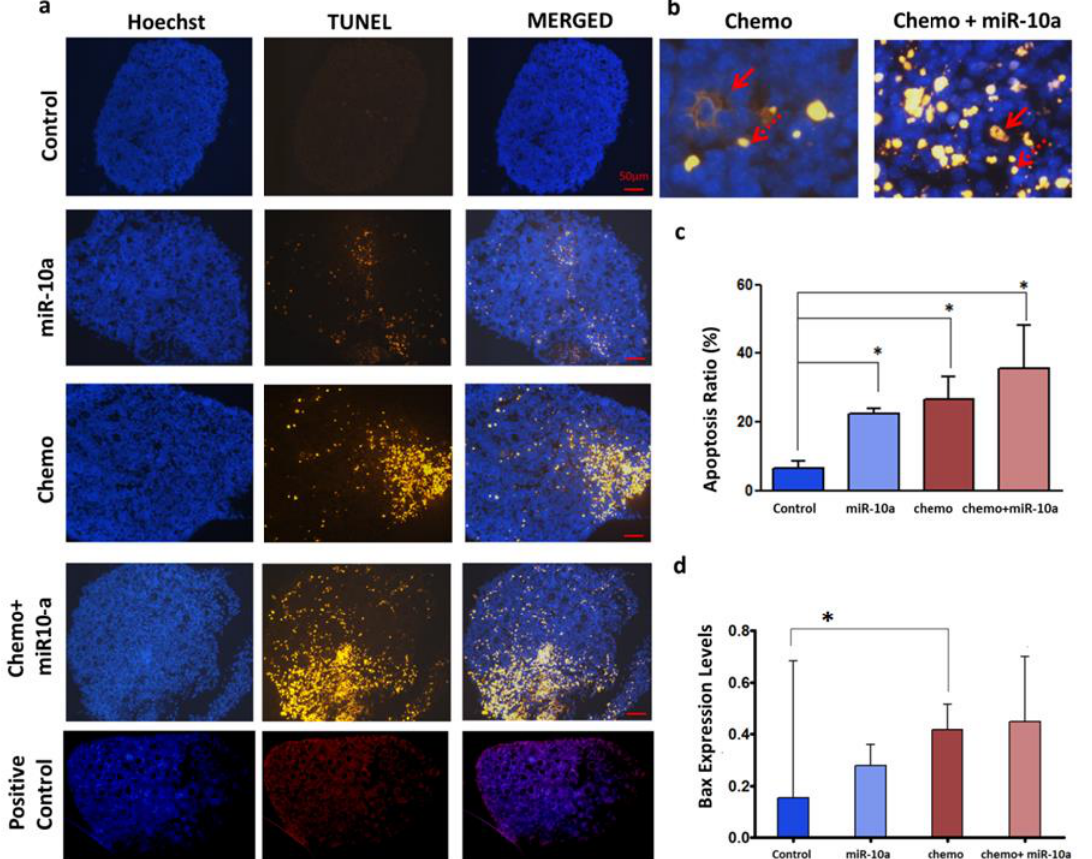
Figure 3. Functional analysis of miR-10a replacement approaches by apoptosis evaluation in PND3 ovaries with or without treatments. Apoptosis evaluation in PND3 ovaries with or without treatments. ( a ) Ovarian sections (5 µ m) show nuclear labeling with Hoechst (blue) and apoptotic cells / TUNEL positive (yellow / red). After two days in culture, apoptosis was higher in the miR-10a mimic compared to the control group. The apoptosis level in ovaries treated with chemo (1 h / 4-HC / 20 µ M) + miR-10a exhibit the highest rate of apoptosis compared to the control ( p < 0.05). ( b ) Magnified merged (Hoechst / TUNEL) images of chemo and chemo + miR-10a groups indicate apoptotic oocytes (red arrow) and apoptotic granulosa cells (dashed arrow). ( c ) Quantification of apoptotic cells. The TUNEL-positive cells were quantified and expressed as a percentage of the total cells stained with Hoechst. The results are displayed as the mean of individual measurements ( n ≥ 3). ( d ) The expression levels of Bax were quantified in the four groups. There is a trend of increasing Bax expression in treated groups (miR-10a, chemo, chemo + miR-10a), but the expression is significantly upregulated in the chemo group compared to the control ( n = 7). The error bars represent the standard error, paired t-test, * p < 0.05.